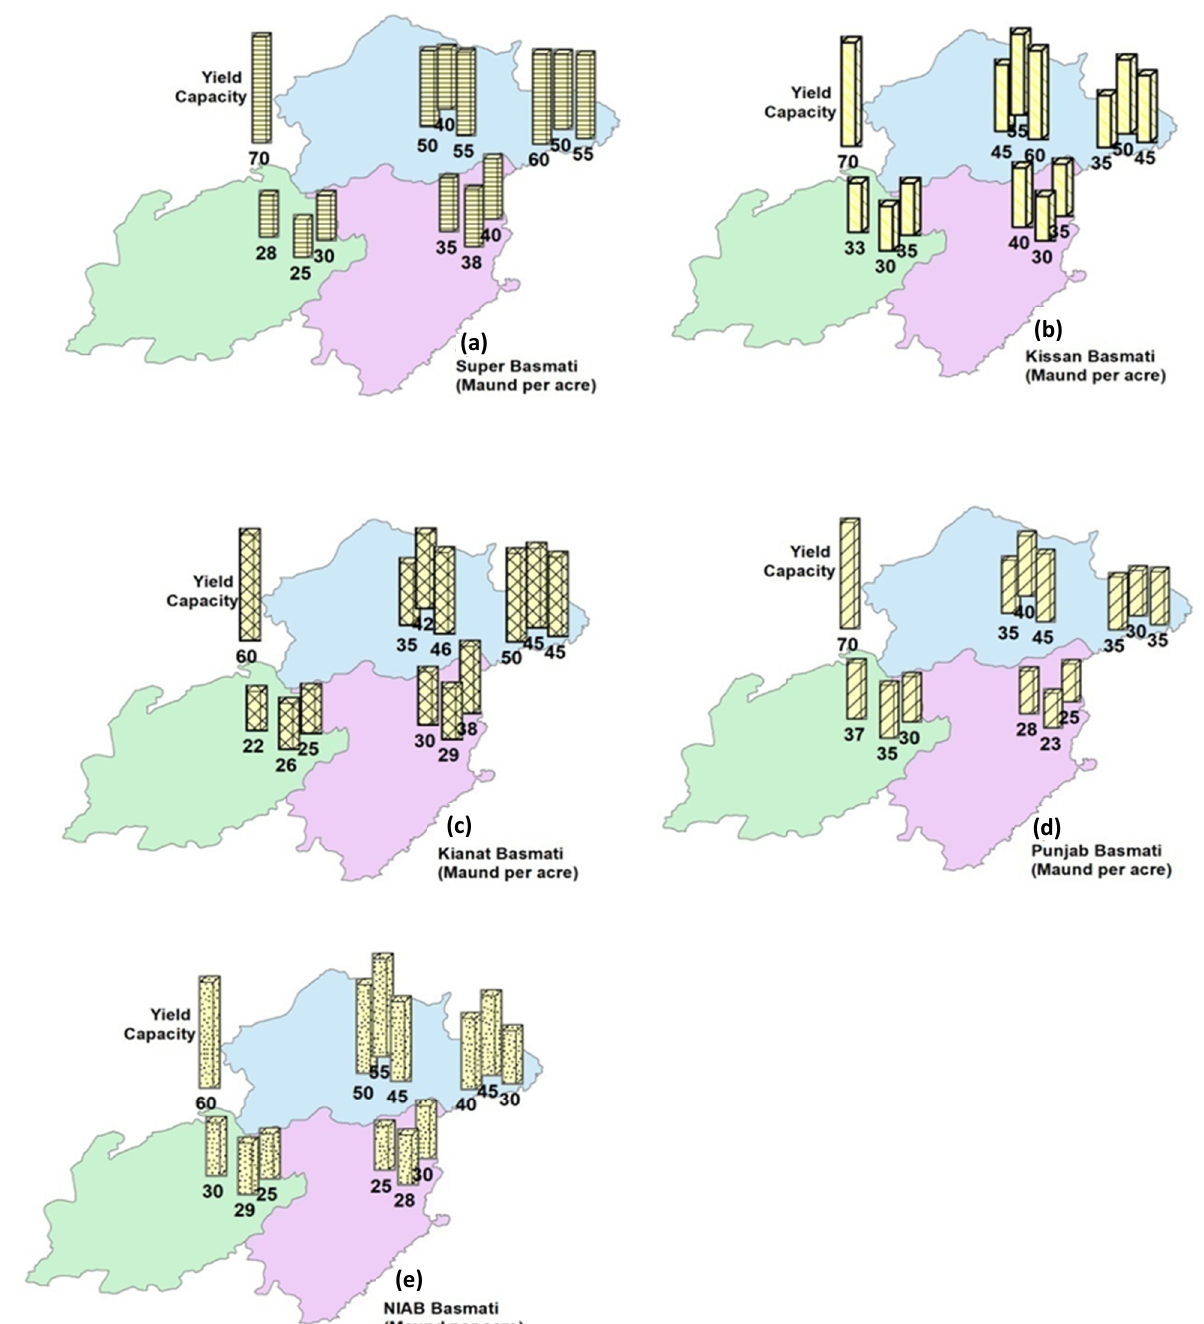
Figure 2. Maps showing the distribution of rice productivity (maund per acre; 40 kg = 1 maund) in the selected areas of Punjab, Pakistan. The yield capacity (potential) and actual yield of selected fragrant rice cultivars (Kissan basmati, NIAB basmati, Punjab basmati, Kainat basmati, and super basmati) investigated in this study are also shown as vertical bar graphs for comparison.